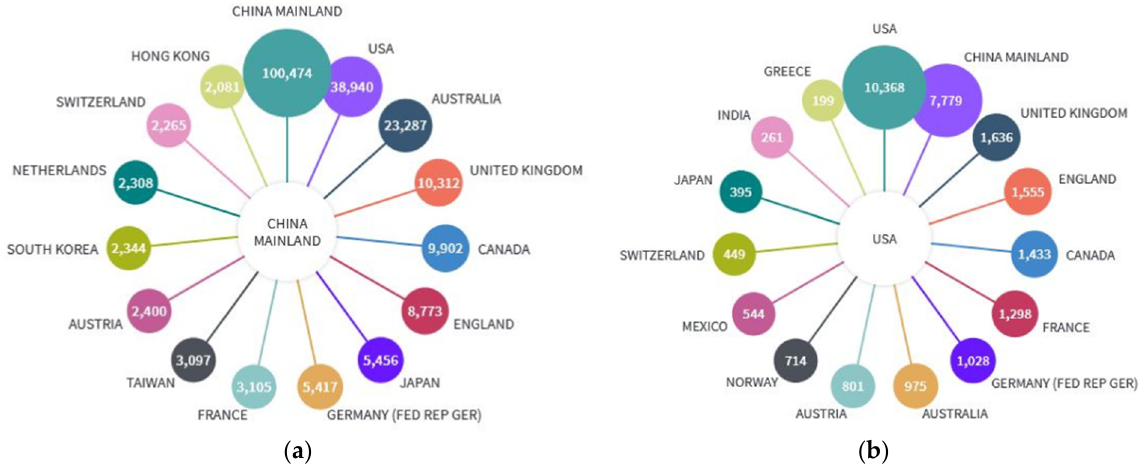
Figure 4. International collaboration expressed in citation counts for China ( a ) and USA ( b )–top 15 countries.